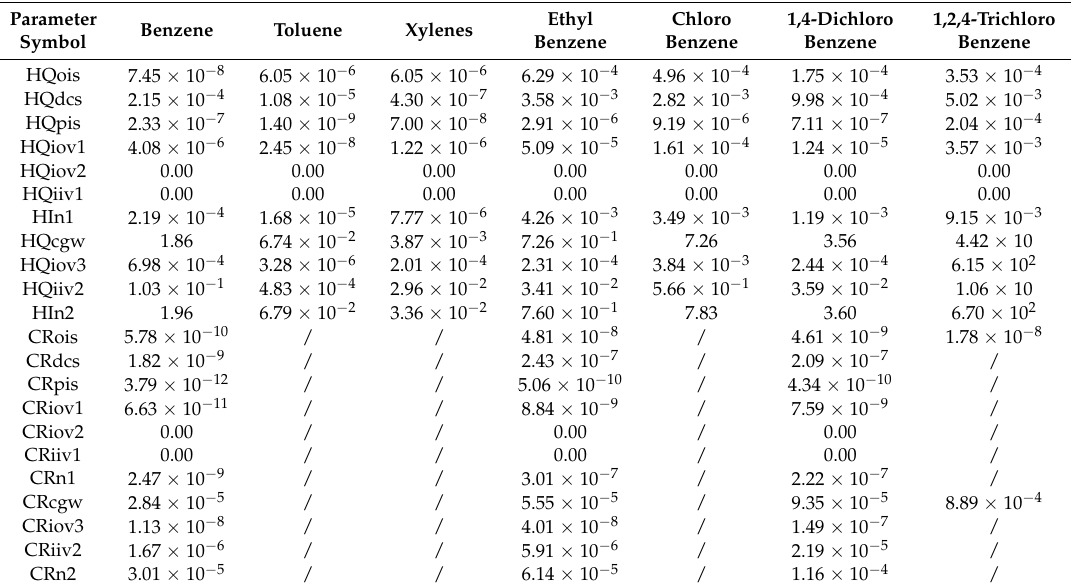
Table 5. Hazard quotient (HQ—systemic toxicity) and carcinogenic risk (CR) of contaminants for different potential human exposure routes at the Luhe